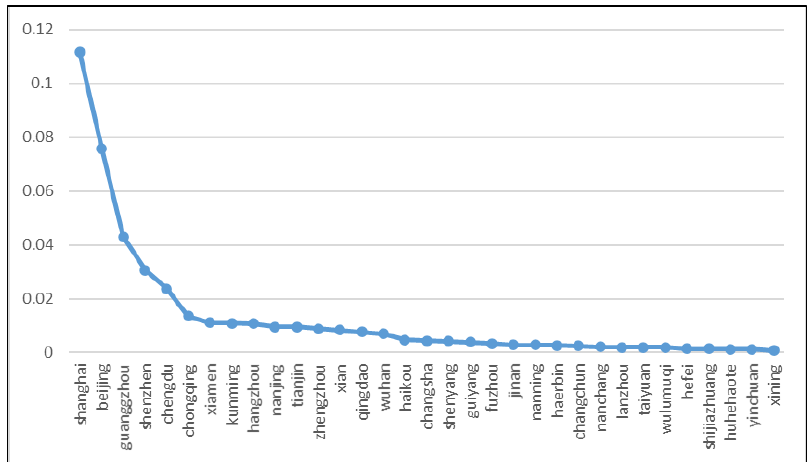
Figure 4. The indirect effect of per capita GDP on cargo traffic in different regions.